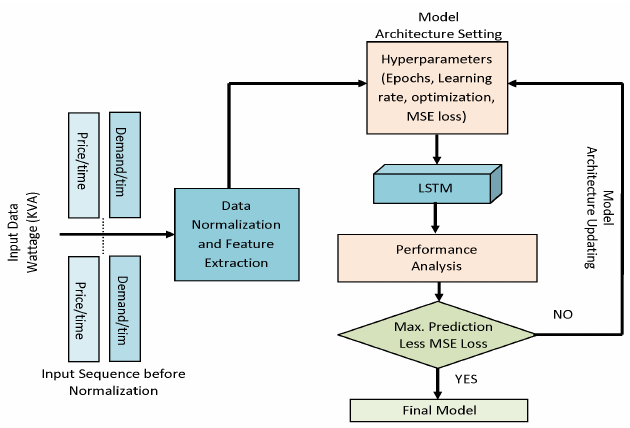
Figure 3. The flow diagram of the LSTM Model